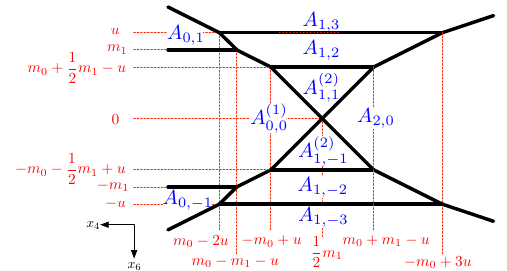
Figure 21. The regions for the largest A ( m ) Region 1 of the E 2 theory.